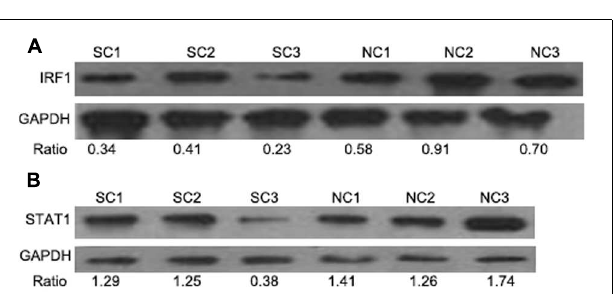
FIGURE 4 | Western blot analysis of IRF1 and STAT1 levels in the late phases of ALV-J infection. IRF1 and STAT1 expression in the spleens of chickens with neoplasms (SC1–3) compared to healthy controls (NC). (A,B) represent the detection of IRF1 and STAT1 using WB,